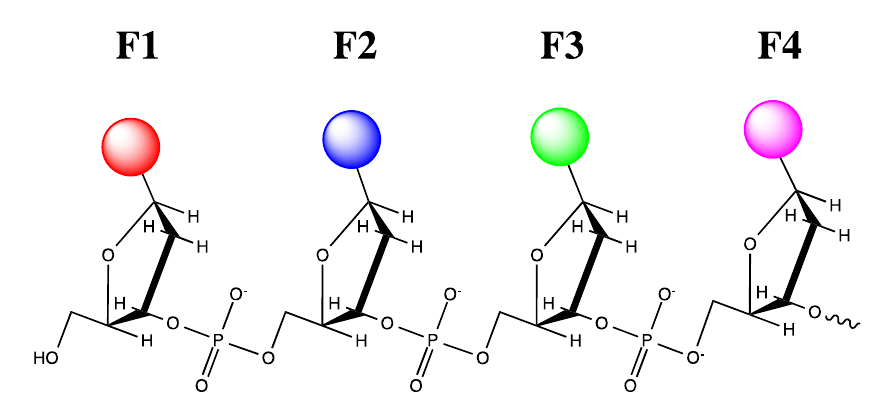
Figure 10. “Oligodeoxyfluorosides” (F1, F2, F3, F4, … —different fluorophore